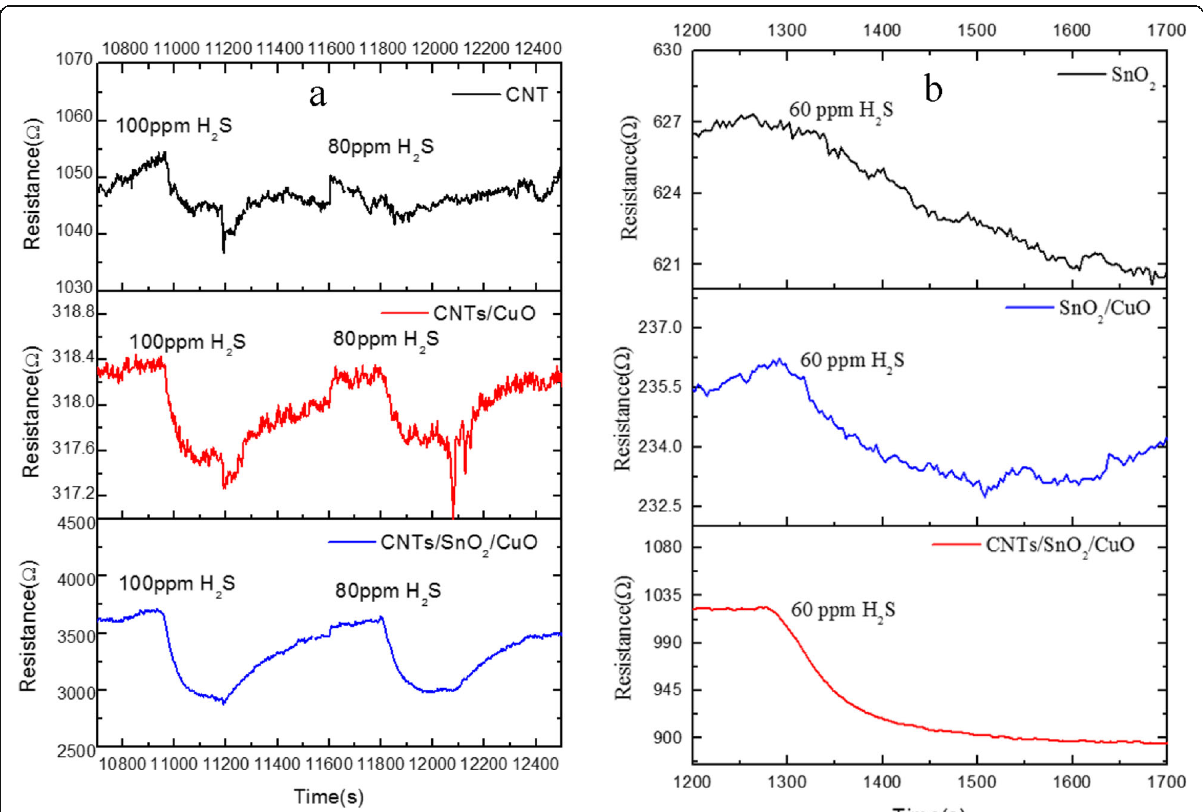
Fig. 6 a , b Comparison of performance of nanocomposite in detecting H 2